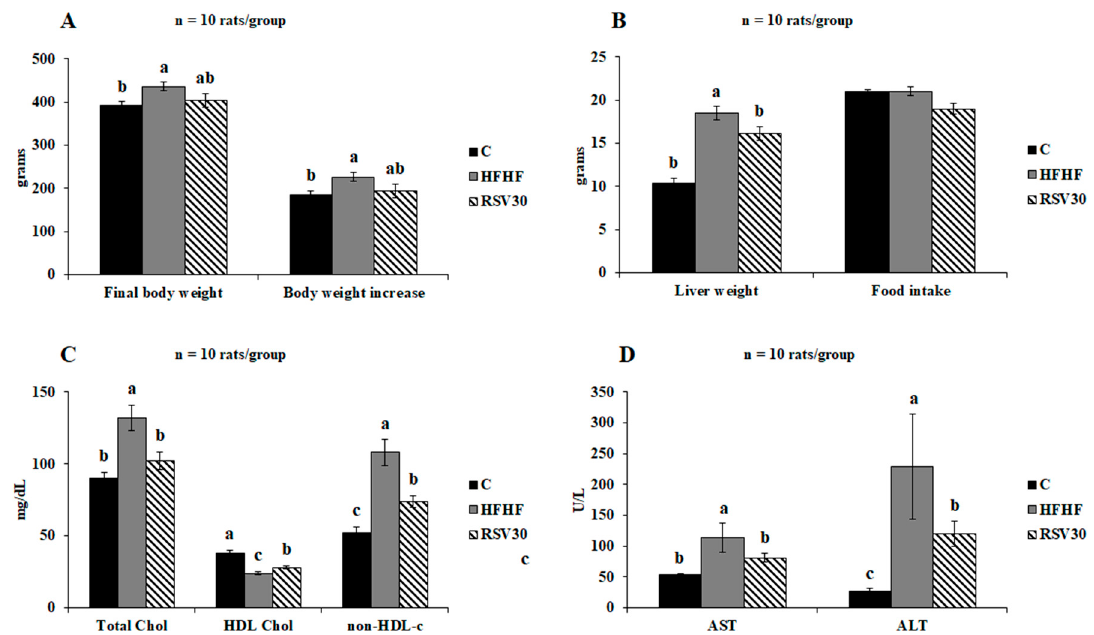
Figure 1. Final body weight and body weight increase ( A ), liver weight and food intake ( B ), serum total, HDL, and non-HDL cholesterol levels ( C ) and serum aminotransferase levels ( D ) in rats fed a control diet ( C ), a high-fat high-fructose diet (HFHF) or a high-fat-high-fructose diet supplemented with 30 mg/kg/d resveratrol (RSV30). Values are presented as mean ± SEM. Bars not sharing common letters are significantly different ( p < 0.05). ALT: alanine aminotransferase, AST: aspartate aminotransferase.